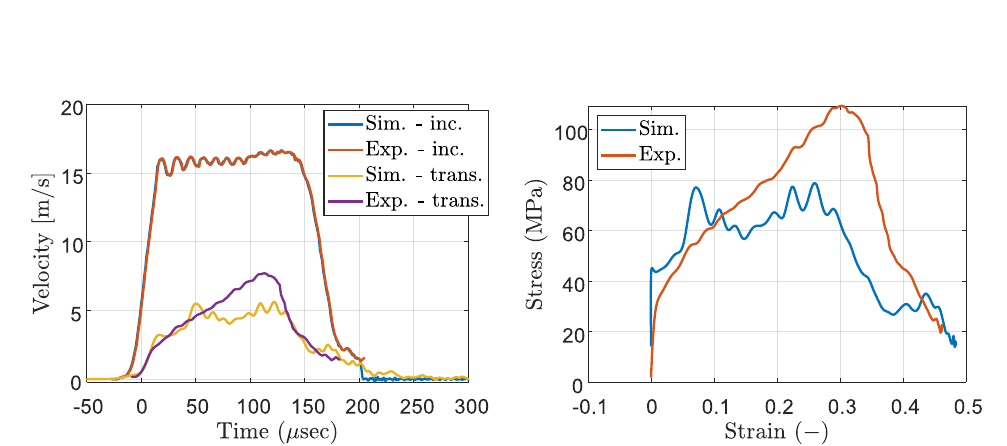
Figure 2. Test comparison with simulations using quasistatic model a) Velocity vs. time, b) von Mises stress vs. strain